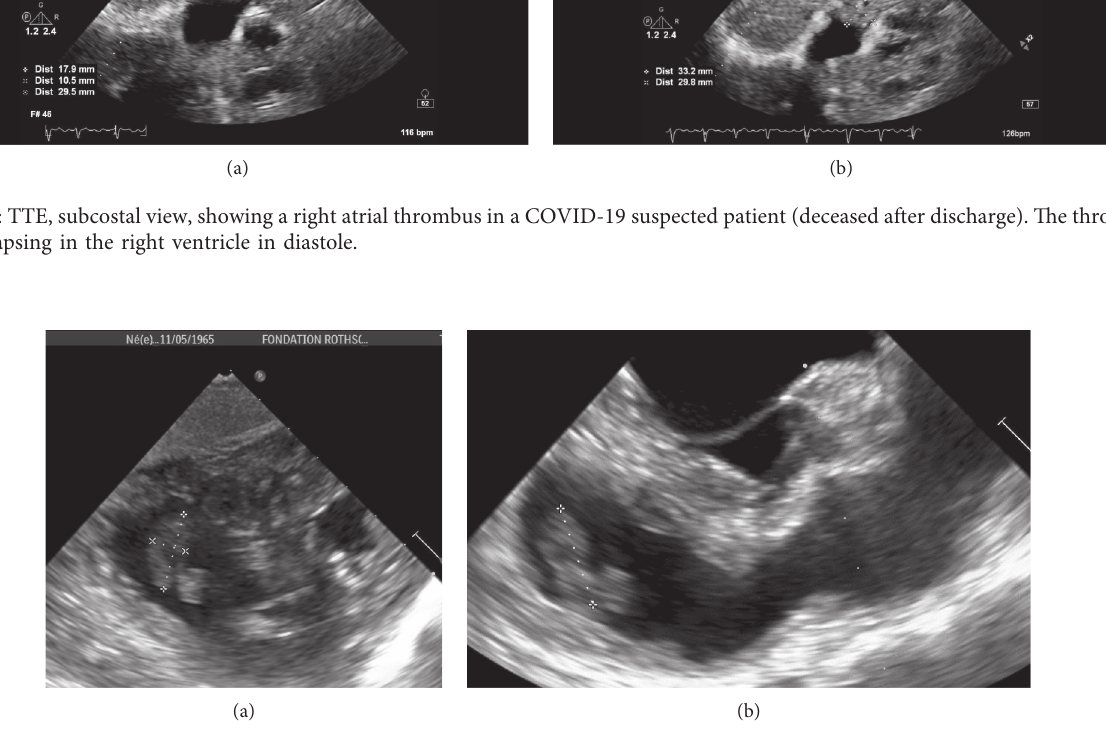
Figure 2: Voluminous and heterogeneous right atrial thrombus seen on TTE (a) and TEE (b). The patient had thrombolysis for severe pulmonary